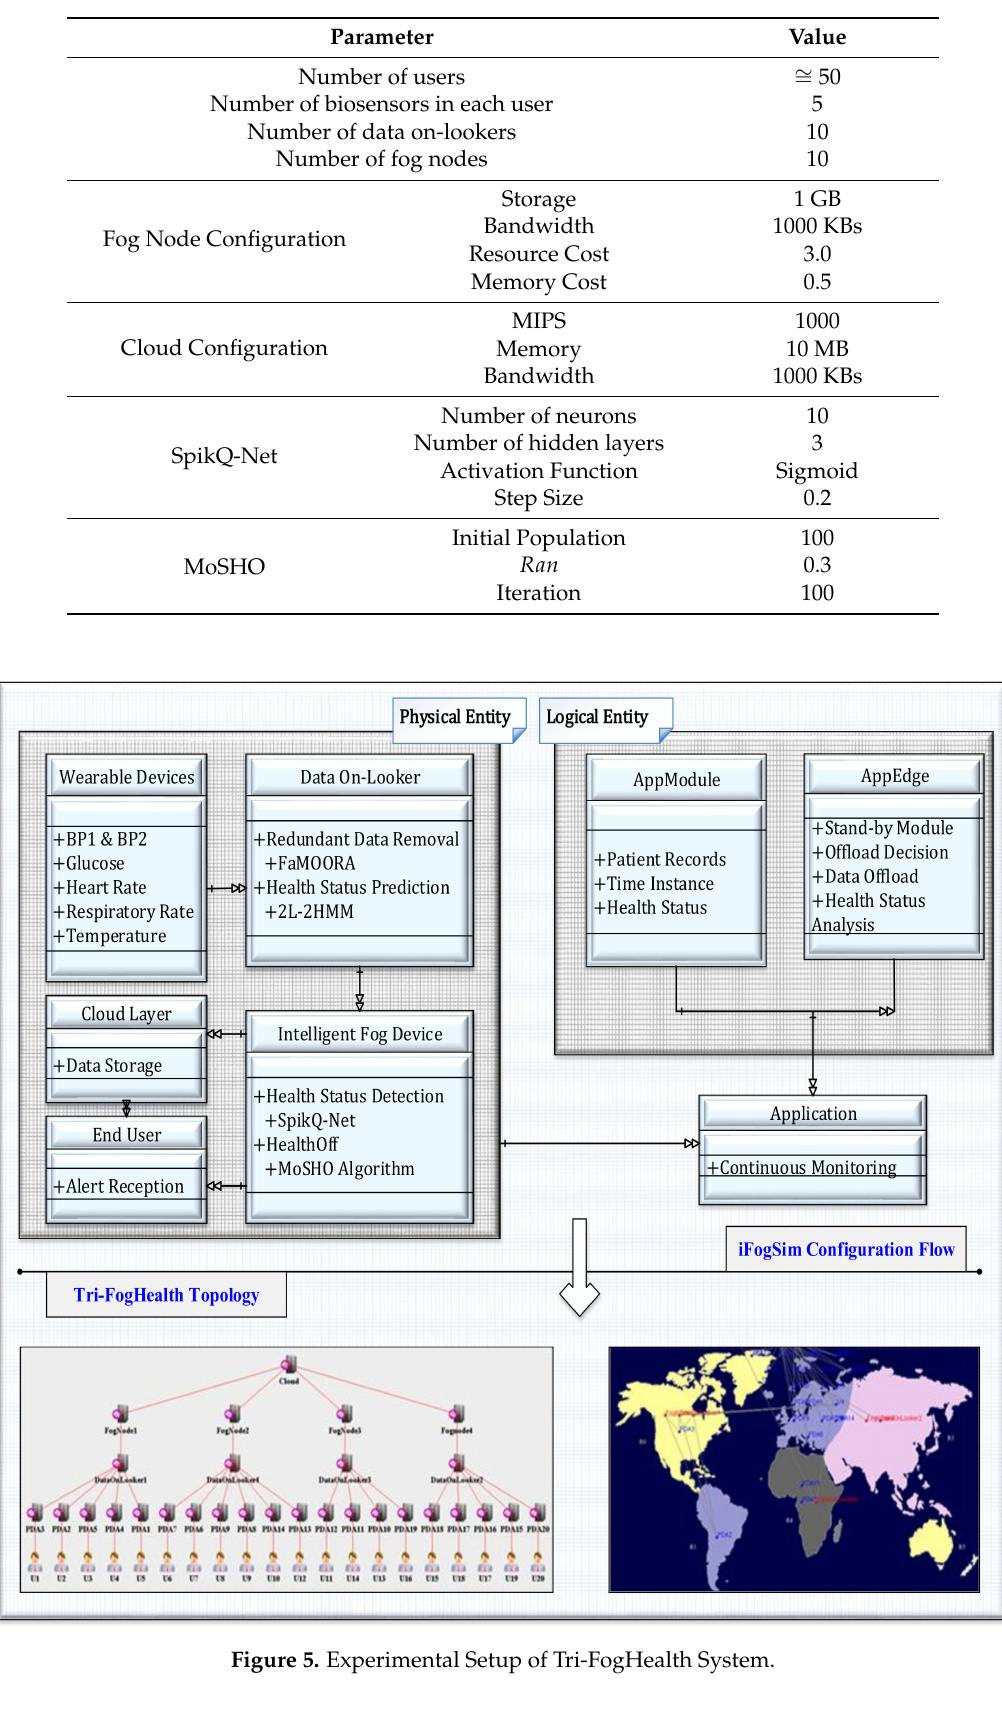
Table 5. Experimental Settings.